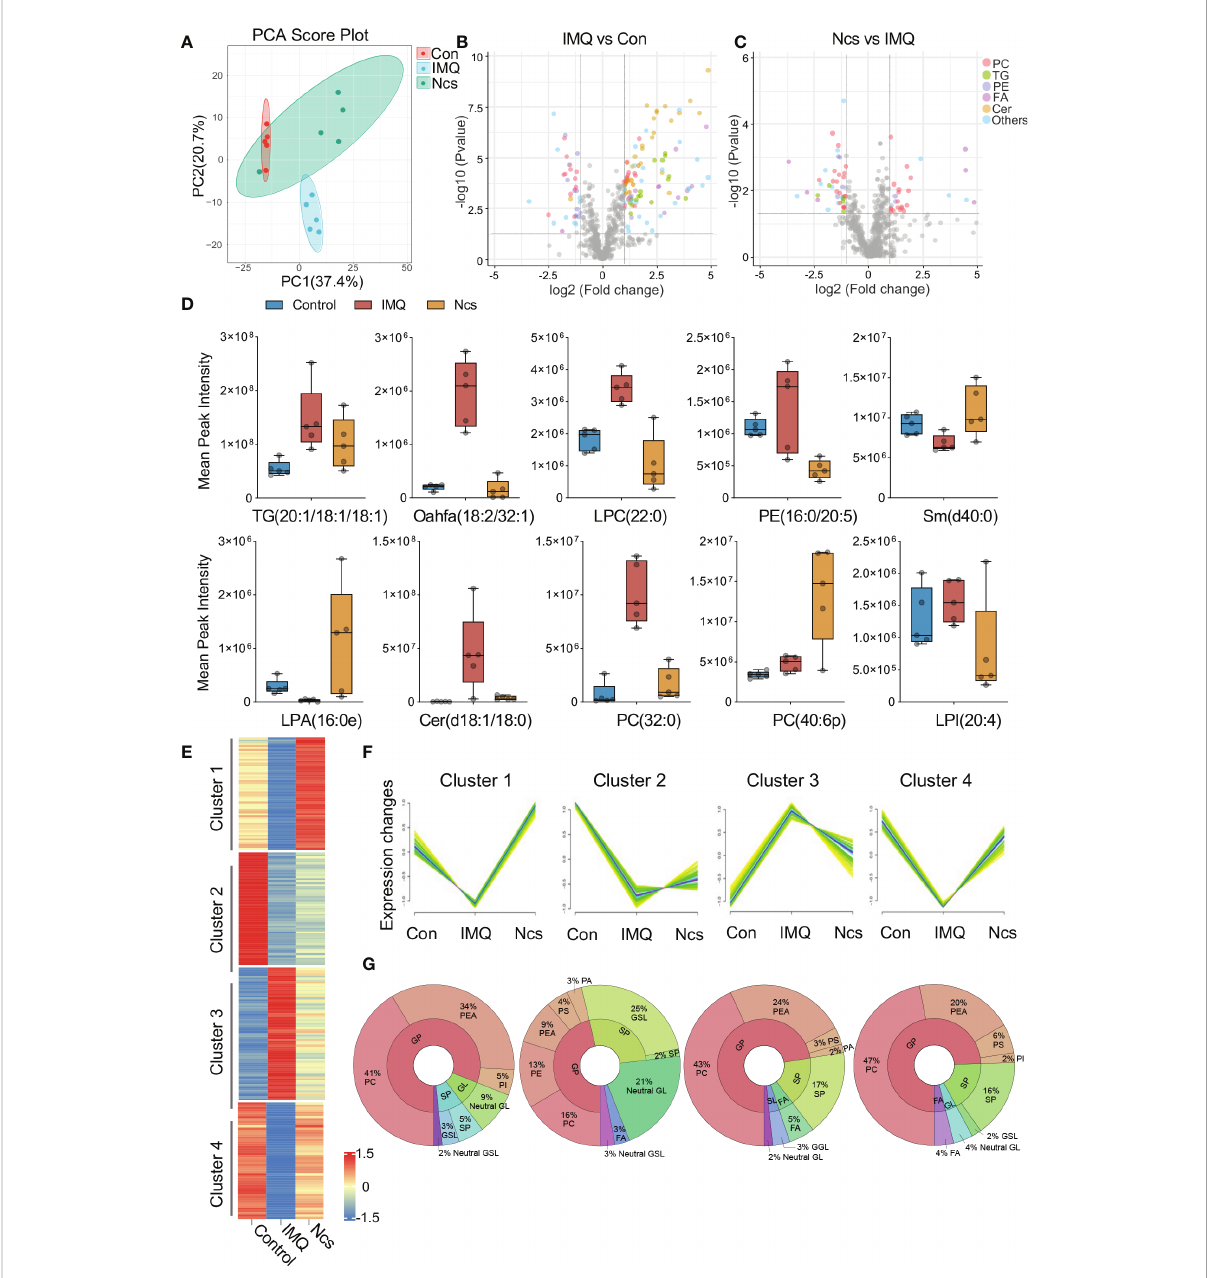
FIGURE 5 Lipidomics analysis of skin lesions in mice with different treatment. (A) PCA clusters samples with similar trends based on the expression pro fi les of lipid metabolites. The 15 samples were clearly separated into three clusters, corresponding to Con, IMQ and Ncs group (n=5). (B, C) Volcano plots of DELs in the comparison of IMQ vs. Con and Ncs vs. IMQ. Different colors correspond to different lipid family. (D) Changes of lipid metabolite levels in skin of mice treated with different treatments. (E) Heat map of 4 representative clusters in hierarchical cluster analysis. (F) trend line of DEL level in the 4 clusters from (B) . (G) Pie charts show the lipid classes and proportions of DELs in each